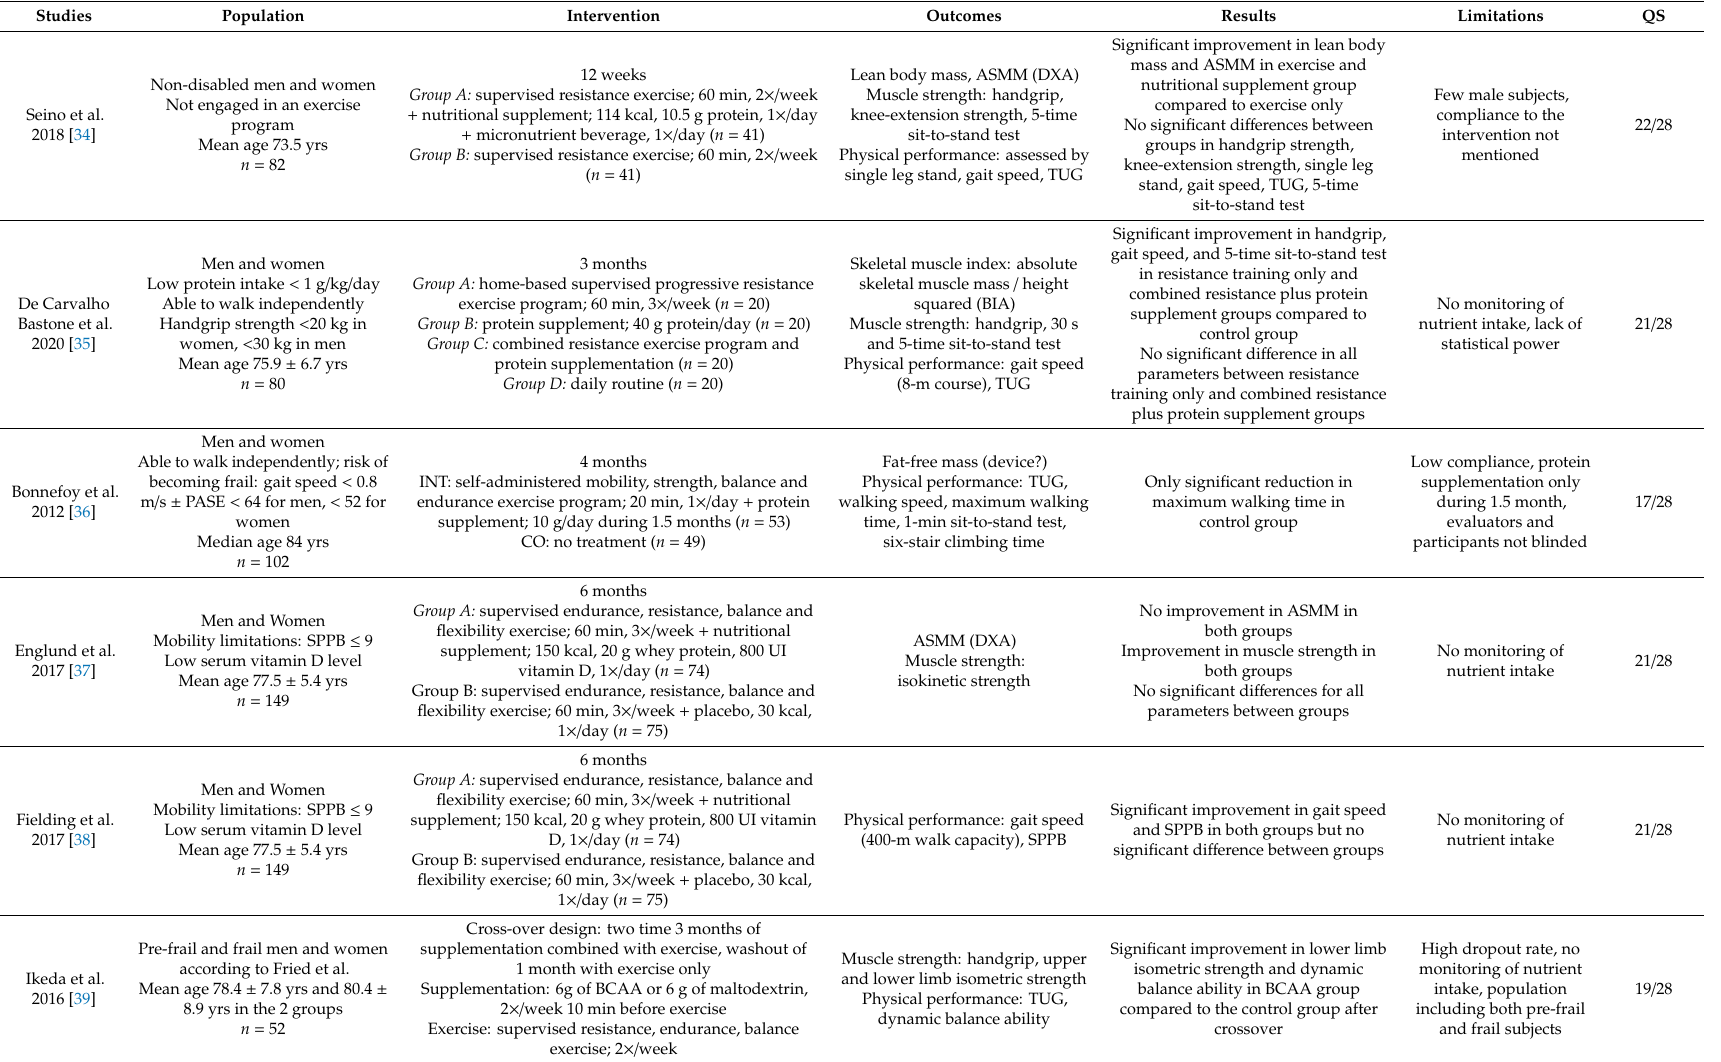
Muscle strength: handgrip, upper and lower limb isometric strength Physical performance: TUG, dynamic balance ability